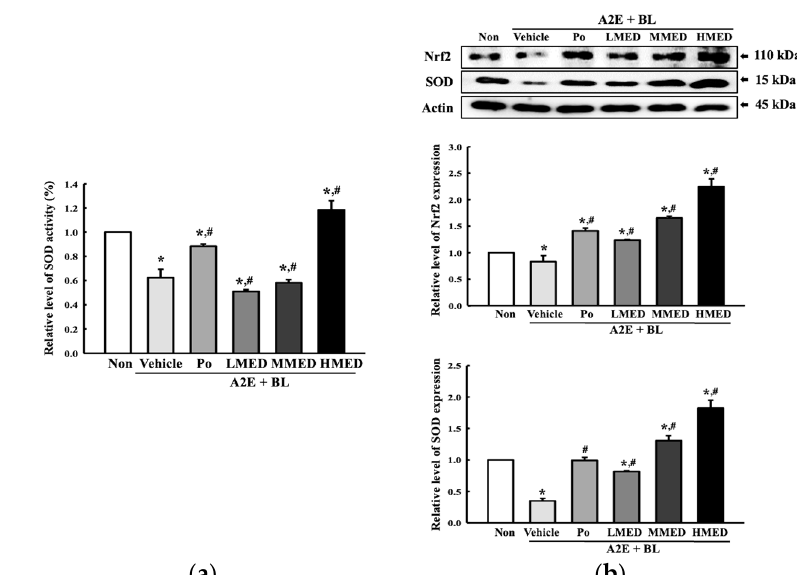
Figure 3. Determination of SOD and Nrf2 expression in MED + A2E + BL treated ARPE19 cells. ( a ) Measurement of SOD activity. SOD activity was measured in total cell lysate of ARPE19 cells using SOD assay kit. One SOD unit was defined as described in materials and methods. ( b ) Expression of SOD and NRF2 protein. After preparing total cell lysate from MED + A2E + BL treated ARPE19 cells, the expression level of SOD and Nrf2 protein was measured by Western blotting analysis. The total proteins homogenates were prepared from two to three samples per group, and Western blot anal- yses for each sample was analyzed in duplicate. All values in results are represented as the means ± standard deviation (SD). * indicated statically significance compared to the Non treated group, while # indicated statically significance compared to the Vehicle + A2E + BL treated group. Abbre- viations: SOD, Superoxide dismutase; Nrf2, Nuclear factor erythroid 2–related factor 2; MED, meth- anol extracts of Dipterocarpus tuberculatus Roxb.; A2E: N-retinylidene-N-retinylethanolamine; BL, Blue light; WST-1, water-soluble tetrazolium salt-1.